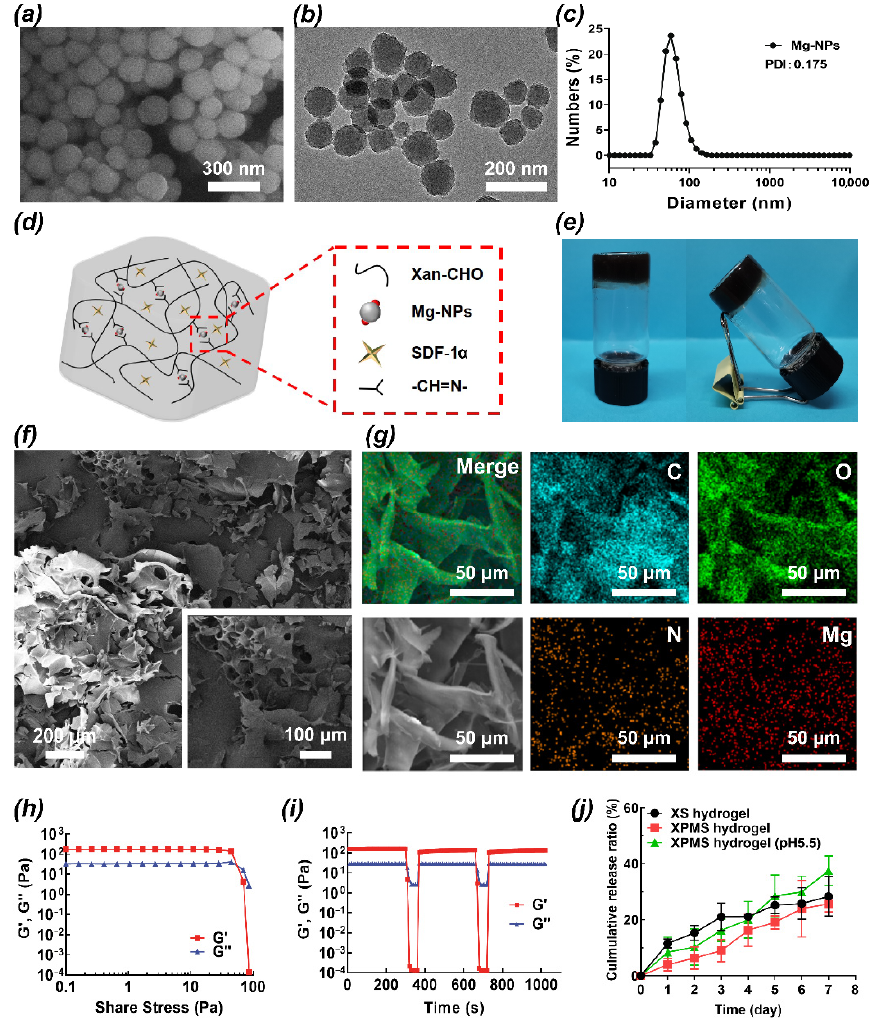
Figure 1. Characterization of XPMS hydrogel. SEM ( a ) and TEM ( b ) images of Mg-NPs. ( c ) Hydro- dynamic size distribution profile of Mg-NPs. ( d ) Schematic illustration of the structure of injectable XPMS hydrogel crosslinked by Schiff base bonds. Digital photograph ( e ), SEM images ( f ), and cor- responding element mappings (C, O, N, and Mg) ( g ) of XPMS hydrogel. ( h ) Shear stress sweep tests of the XPMS hydrogel at 37 °C. ( i ) Self-healing ability of the XPMS hydrogel evaluated with different torques at room temperature. ( j ) Cumulative release ratio of SDF-1 α from the XPMS hydrogel under different conditions in vitro.